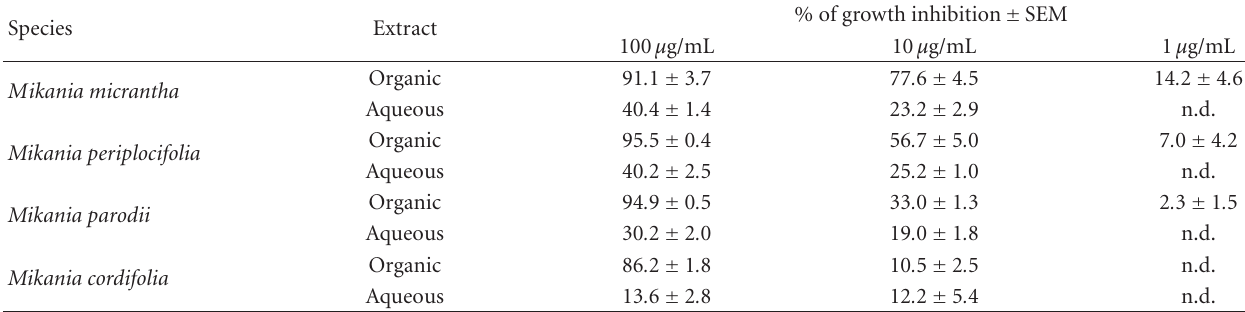
Table 1: Trypanocidal activity of organic and aqueous extracts of Mikania micrantha , M. periplocifolia , M. parodii, and M. cordifolia. Species